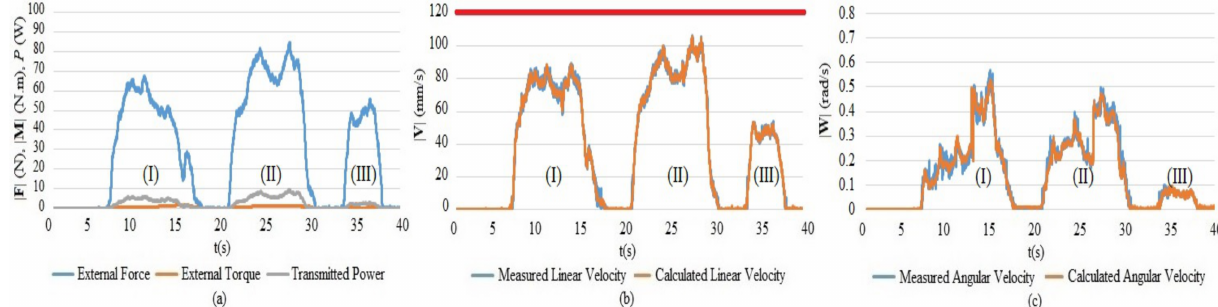
Figure 12. Experimental results using fuzzy-based admittance controller, ( a ) presents the inputs | F | (N), | M | (Nm) and P (W); ( b ) and ( c ) present outputs | V | (mm/s) and | W | (rad/s), respectively.